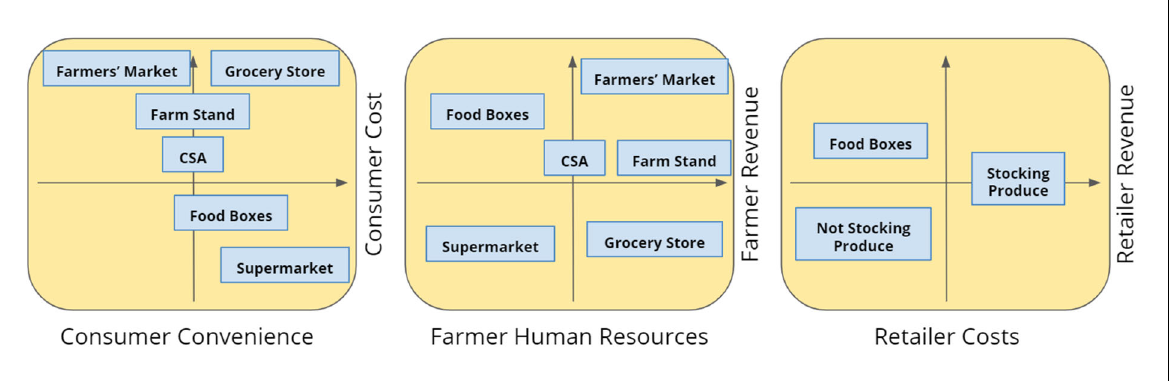
Figure 1. Comparison of Different Alternative Food Systems Models for Consumers, Farmers, and Retailers